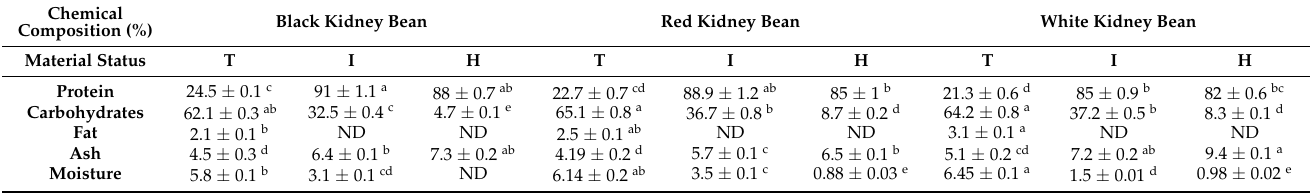
Table 1. Chemical composition of total seed material (T), protein isolate (I) and protein hydrolysate (H), isolated from black, red, and white kidney bean seeds.